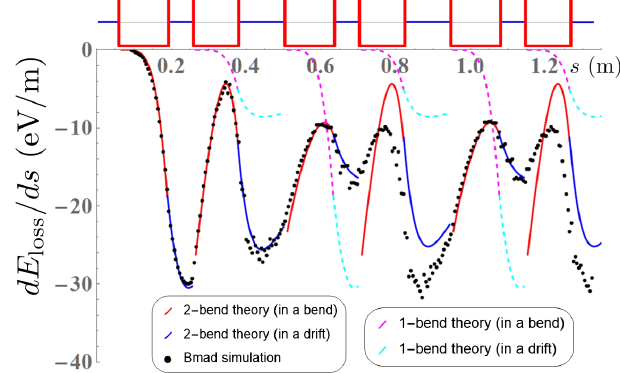
FIG. 21. The CSR energy loss in the first six magnets of the CBETA FA section. The top bar shows the layout of the beamline. The red and blue solid curves come from the two- bend theory, and the magenta and cyan dashed curves come from the one-bend theory. For s < 0 . 255 m the solid and dashed curves overlap. The black dots are from Bmad